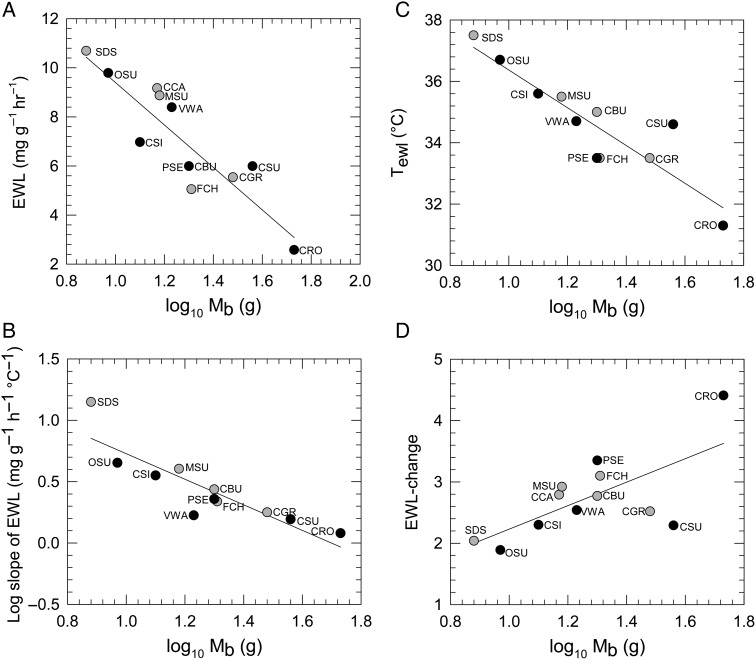
Evaporative water loss (EWL, approximating levels within the thermoneutral zone; A), rates of increase in EWL above inflection air temperature for EWL (log10 slope of EWL; B), inflection air temperatures for EWL (Tewl; C) and EWL-change (ratio of EWL at Tair = 38°C to EWL at Tair = 30°C; D) were significantly related to log10 body mass (log10Mb). Black circles represent Fynbos endemics and grey circles represent non-endemics. Trend lines represent significant relationships (P < 0.05). Each species' data point is labelled with a three-letter acronym, as in Fig. 1.